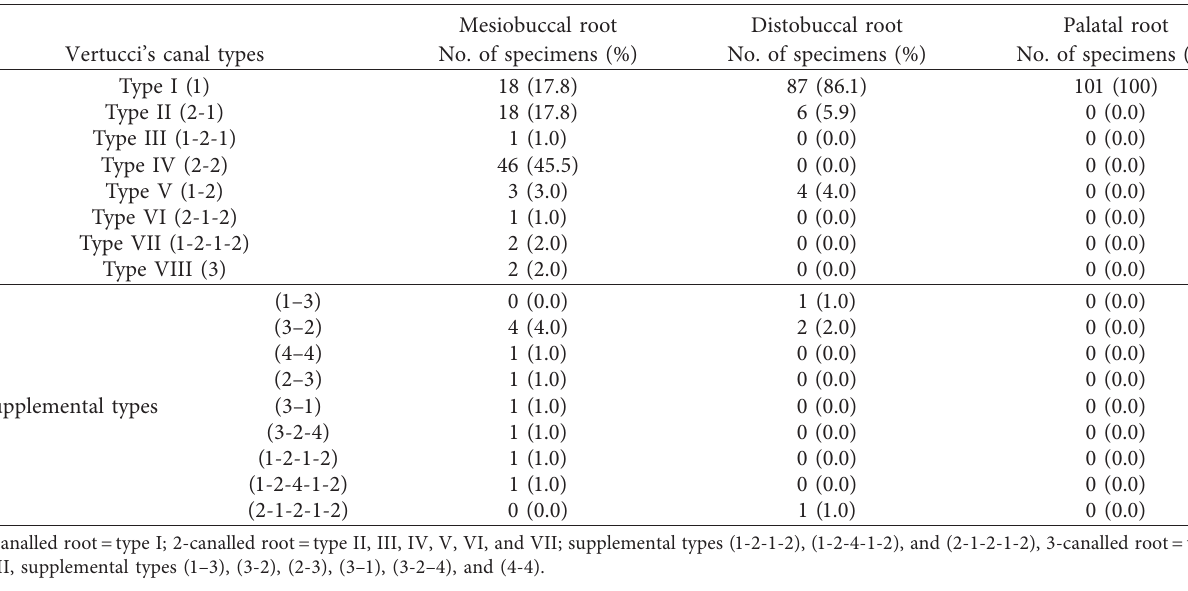
Table 1: Root canal types observed in Burmese maxillary first molar ( n � 101)